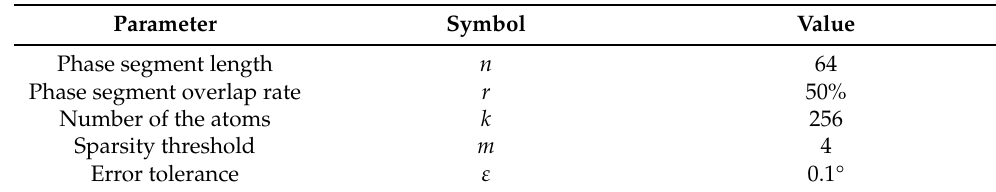
Table 2. Parameters of K-SVD Dictionary Training.